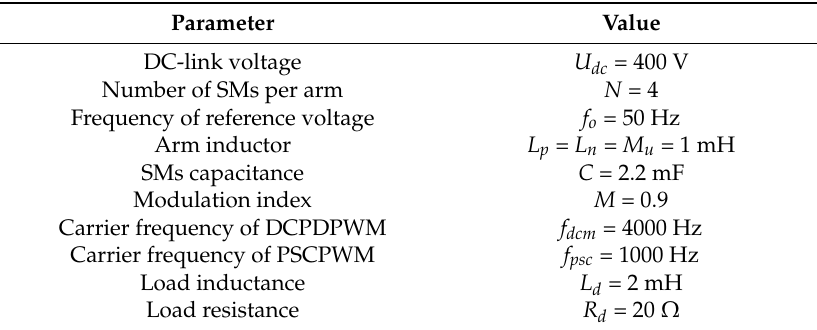
Table 4. Parameters of Prototype.